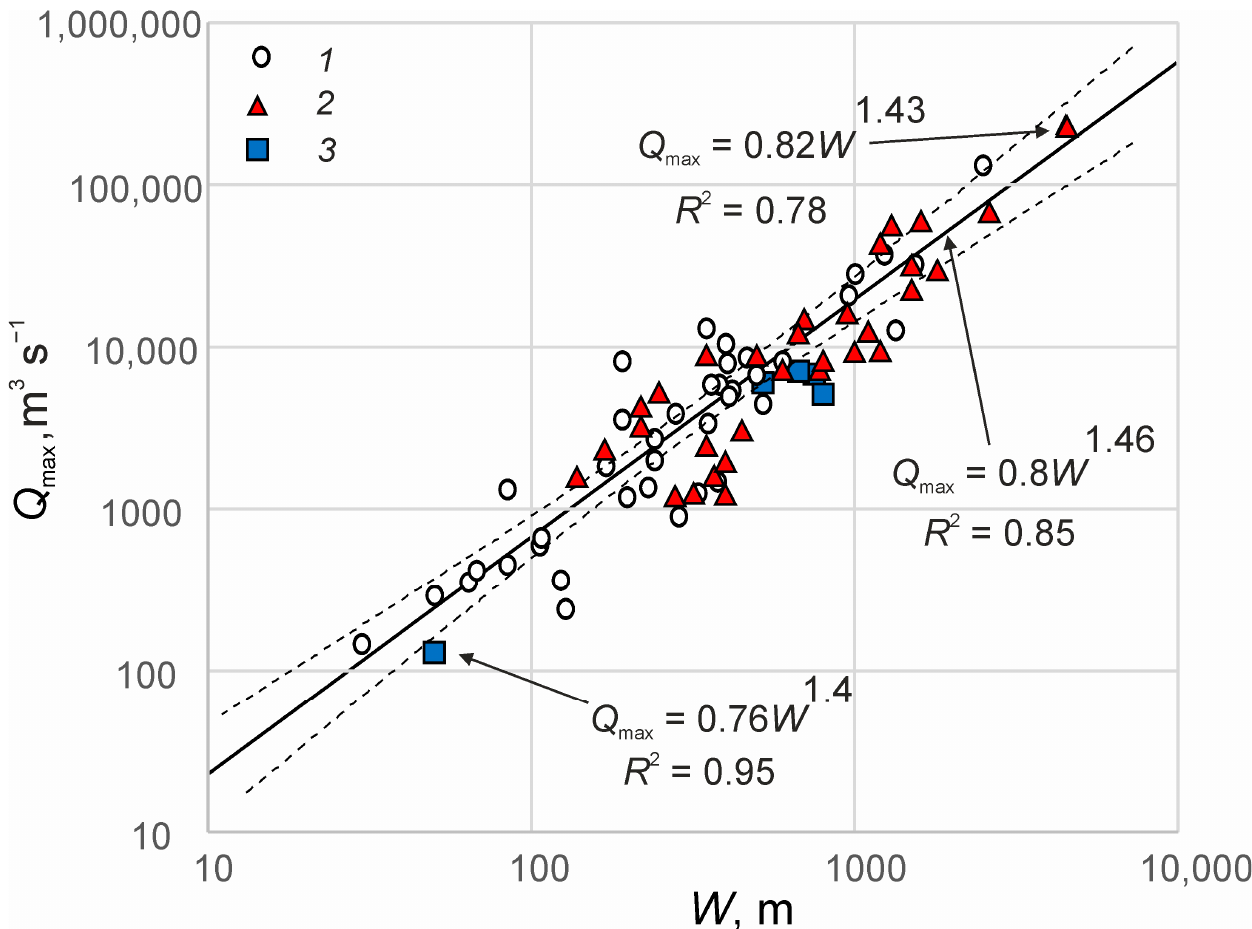
Figure 6. The relationship between the channel bankfull width W and mean maximum discharge Q max for the rivers: (1) of the Lena River basin (Table S3), (2) of equatorial zone river basins (Table S4) and (3) of ancient rivers of the Late Pleniglacial age [12,35].